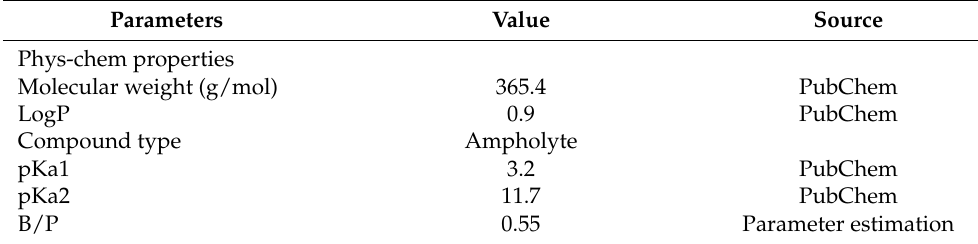
Table 4. Final input parameters for amoxicillin PBPK